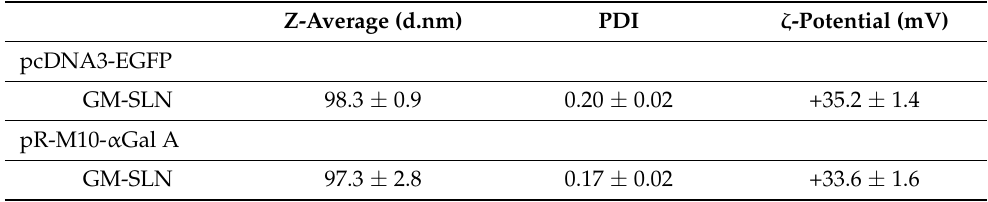
Table 1. Characterization of the GM-SLN vector. Z-Average, polydispersity index and ζ -Potential